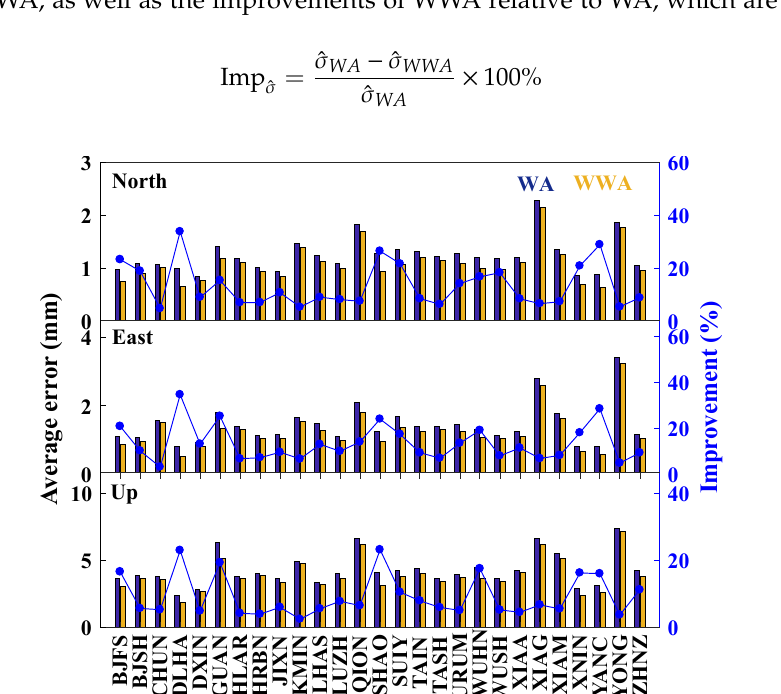
Figure 11. Average errors and relative improvements for all stations.